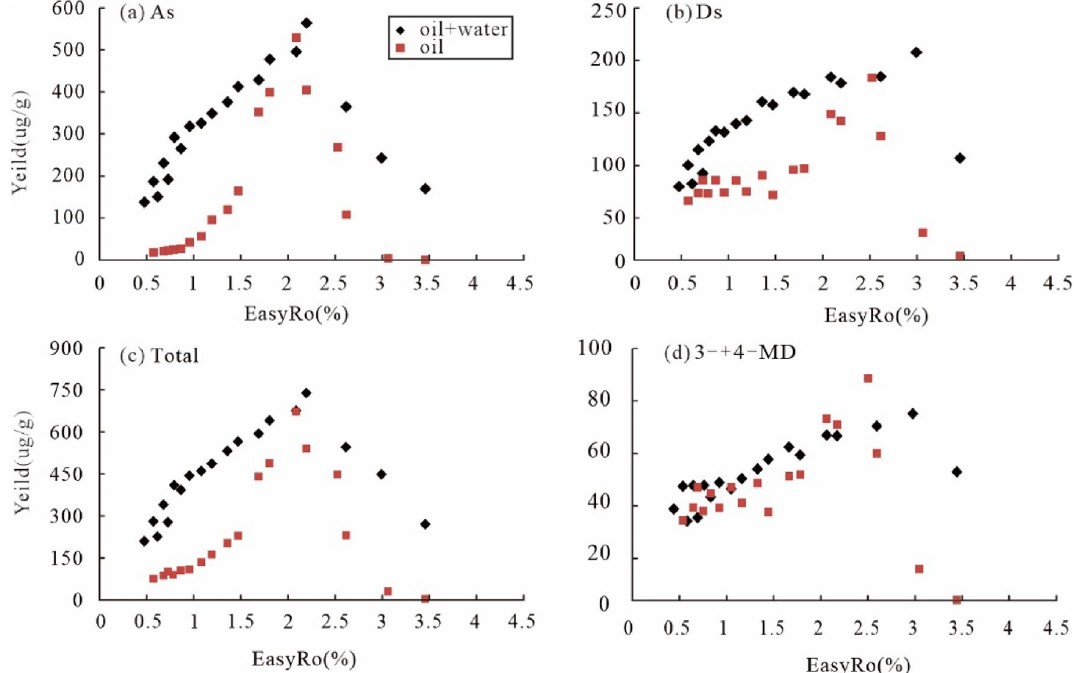
Figure 6. Variation in the yields (µg/g oil) of diamondoids generated from hydrothermal and Fang et al. 13 anhydrous pyrolysis of the same oil with EasyRo (%): ( a ) As, ( b ) Ds, ( c ) Total, ( d ) (3- + 4-) MD. As = total adamantanes; Ds = total diamantanes.